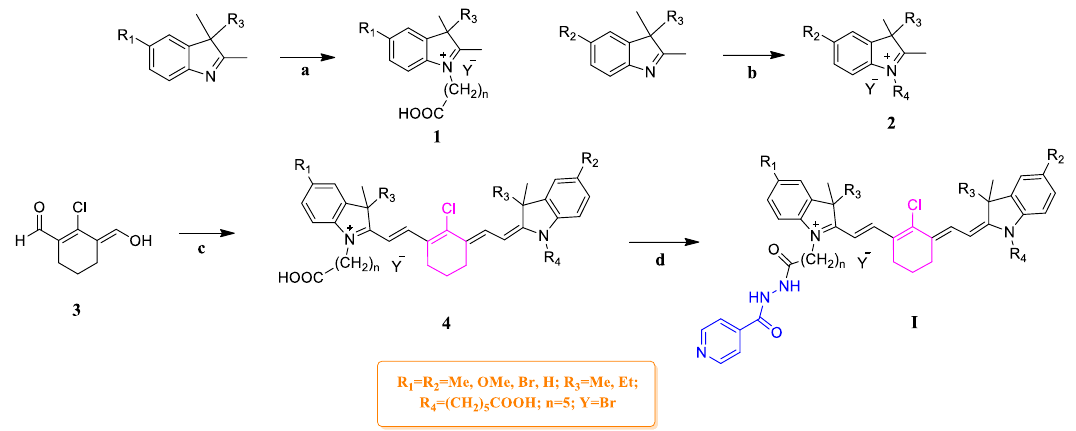
Figure 1. Structures of the designed